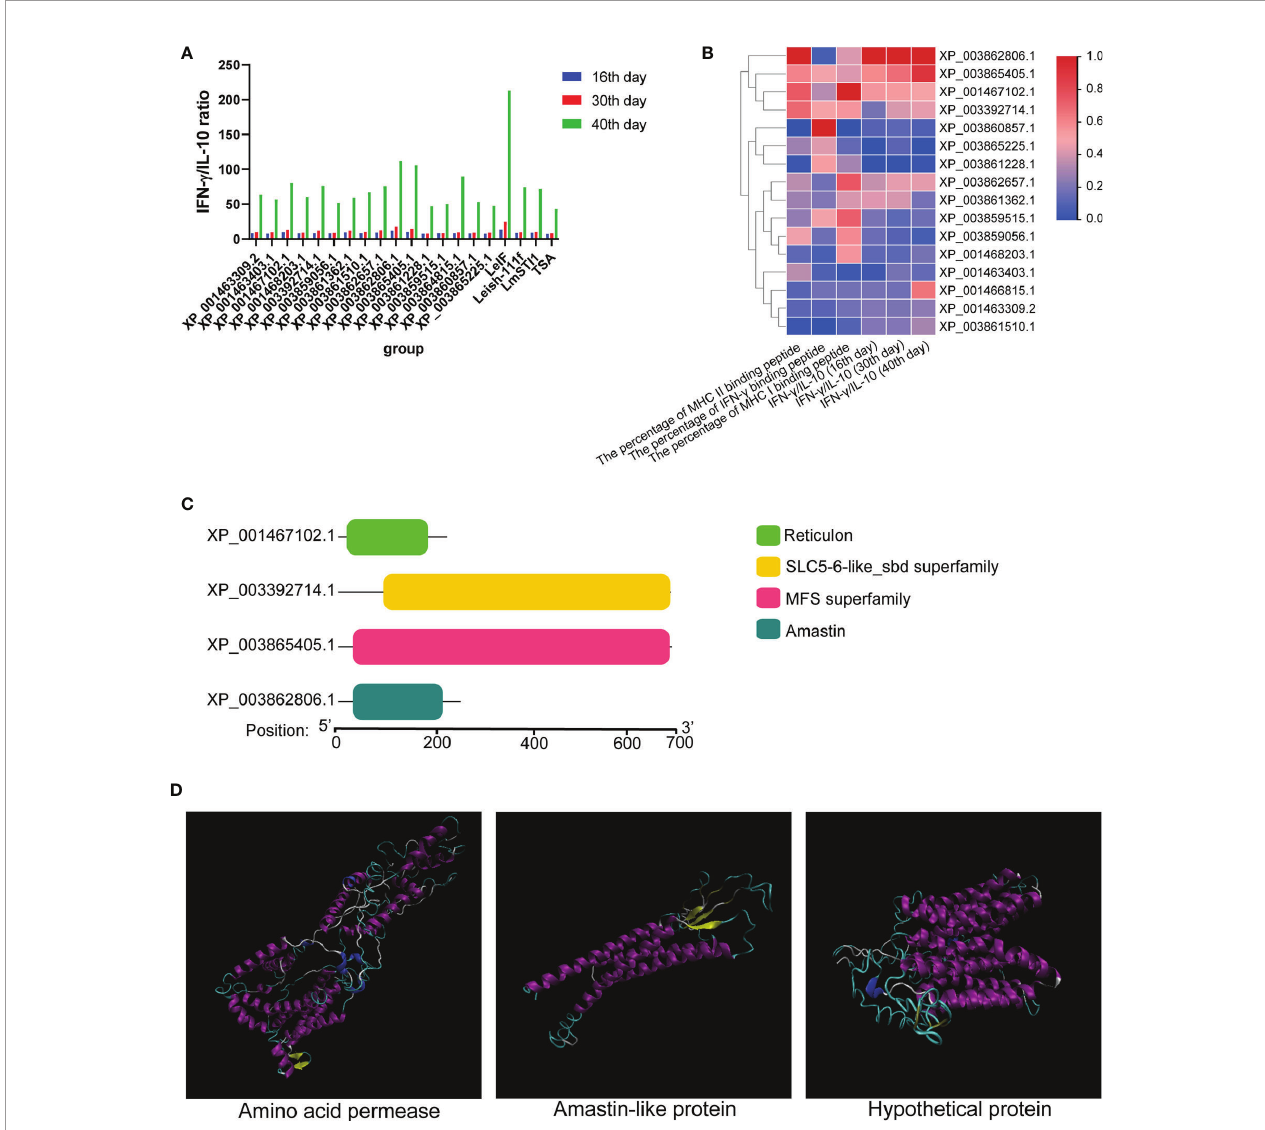
FIGURE 4 | The value of IFN- g /IL-10 and conserved domain. (A) The values of IFN- g and IL-10 from 16 differentially expressed proteins were predicted using C- IMMSIM to evaluate the ratio of IFN- g to IL-10 on 16, 30, and 40 days. (B) Combining with the value of IFN- g /IL-10 and the percentage of MHC II, IFN- g , and MHC I epitopes, 16 differentially expressed proteins were analyzed and represented as a heat map. (C) Amino acid permease (XP_003392714.1), amastin-like protein (XP_003862806.1), the hypothetical protein (XP_003865405.1) and papLe22 protein (XP_001467102.1) were predicted their conserved domain. Amino acid permease (residue 99-696), amastin-like protein (residue 37-206), the hypothetical protein (residue 37-690), and papLe22 protein (residue 20-189) shared a similar conserved domain with SLC5-6-like sbd family, amastin family, major facilitator superfamily (MFS) and reticulon family, respectively. (D) Re fi ned 3D structures of vaccine candidates (alpha helix: purple; extended stands: yellow; beta turn: cyan; random coil: